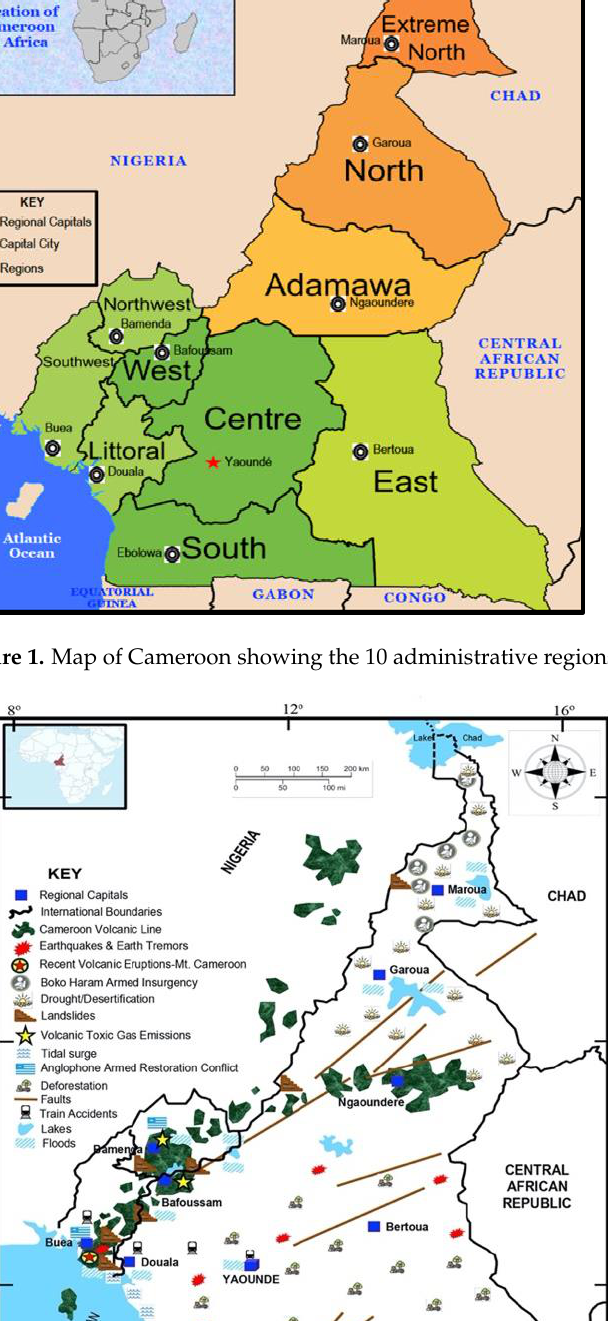
Figure 1. Map of Cameroon showing the 10 administrative regions. Source: Author.